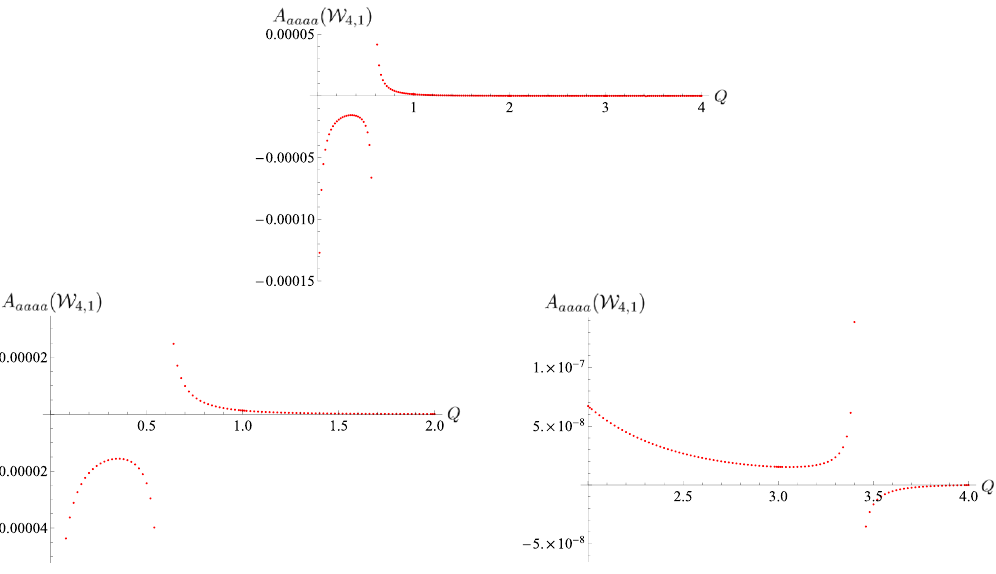
Figure 8 . The bootstrapped A aaaa ( W 2 , 1 ) on the left and the analytic A aaaa ( W 4 , − 1 ) on the right.